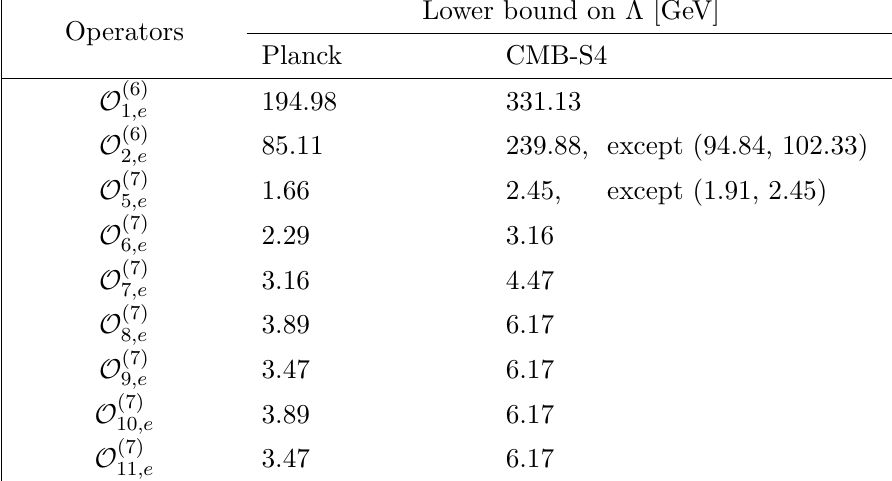
and O (7) , there are exception intervals for 2 ,e 5 ,f from the EFT operators. eff